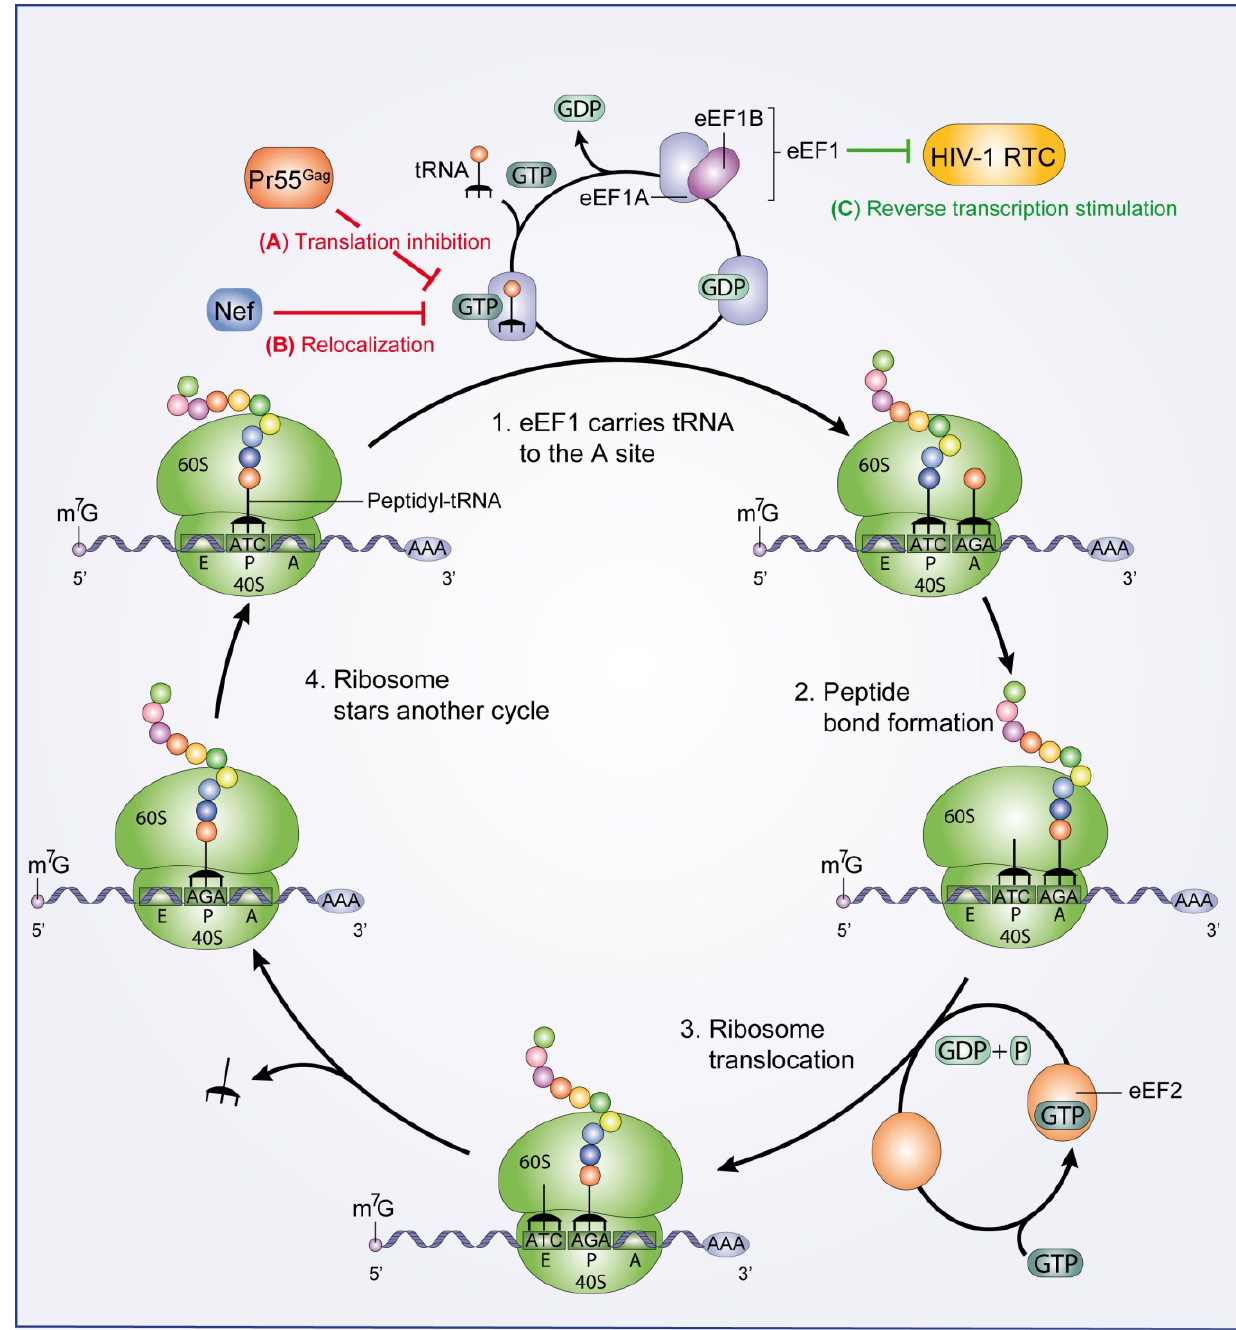
Figure 2. Eukaryotic translation elongation. eEF1A-GTP transports the aminoacylated tRNAs into the A site of the 80S ribosome and eEF1A-GDP is re-activated by eEF1B (step 1). The 80S ribosome-mediated peptide bond formation (step 2) precedes ribosome translocation mediated by eEF2 (step 3). Finally, the ribosome begins another cycle of peptide elongation (step 4). HIV-1 viral functions important to control the eukaryotic translation elongation are shown. ( A ) HIV-1 Pr55 Gag interacts with eEF1A and induces translation inhibition (red line); ( B ) HIV-1 Nef protein also interacts with eEF1A and mediates a nucleocytoplasmic relocalization of eEF1A (red line); ( C ) The HIV-1 RTC recruits eEF1 to stimulate late steps of the HIV-1 reverse transcription process (green